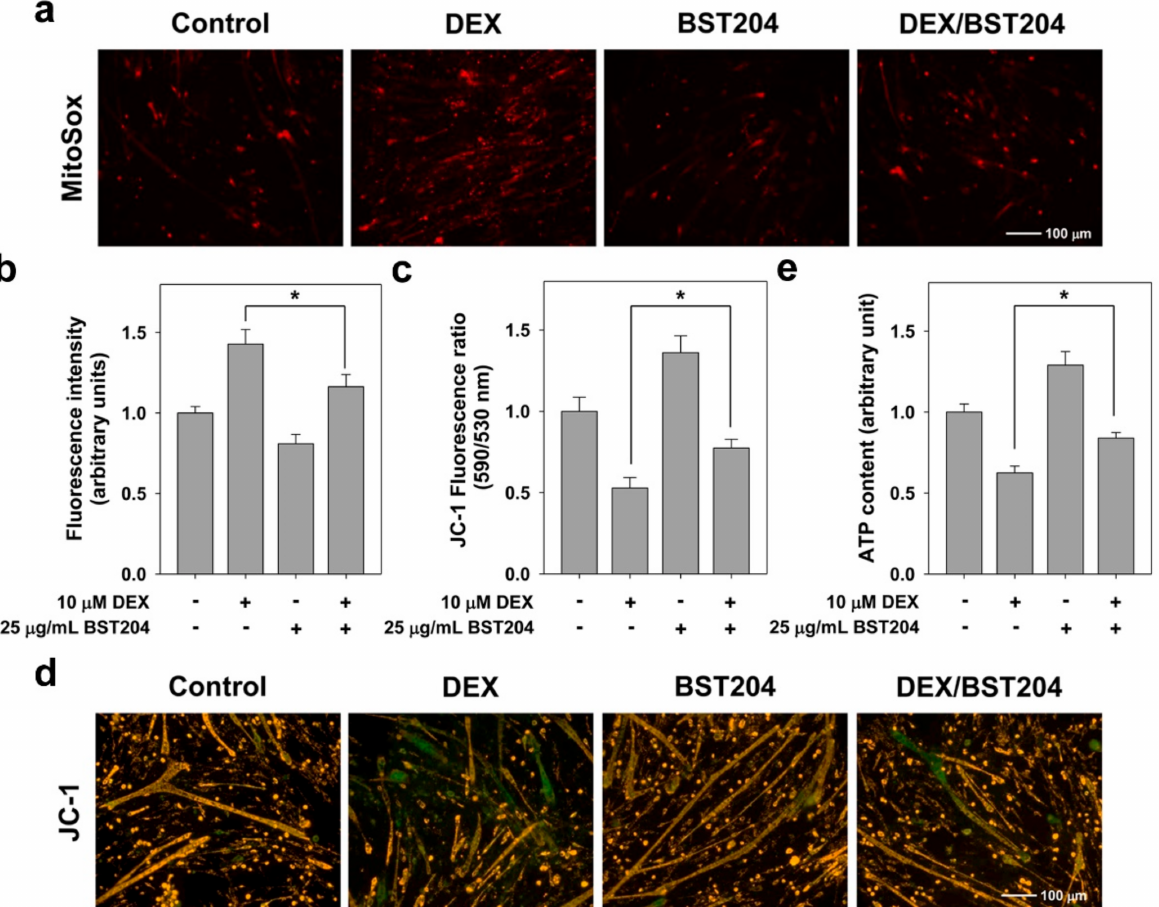
Figure 3. BST204 impedes the production of mitochondrial ROS induced by DEX. C2C12 cells were induced to differentiate in DM for 3 days, and then treated with 10 µ M DEX along with vehicle or 25 µ g/mL BST204 for 1 day. ( a ) Mitochondrial ROS production analysis. Differentiated C2C12 myotubes were stained with MitoSox Red and observed by fluorescence microscope. ( b ) intracellular ROS production analysis using Mitotracker Red CM-H2XRos. Fluorescence intensity is given as arbitrary units and values presented as means ± SD ( n = 4). Significant difference from DEX-treated group, * p < 0.05. ( c ) Mitochondrial membrane potential (MMP) analysis. Fluorescence ratio (590 nm to 530 nm) was used for quantitative analysis. Significant difference from DEX-treated group, * p < 0.05. ( d ) Analysis for MMP by JC-1 staining. ( e ) The determination of ATP content. The total ATP content was measured using ATP Determination Kit. Values presented are as means ± SD ( n = 5). * p < 0.05 compared with DEX-treated